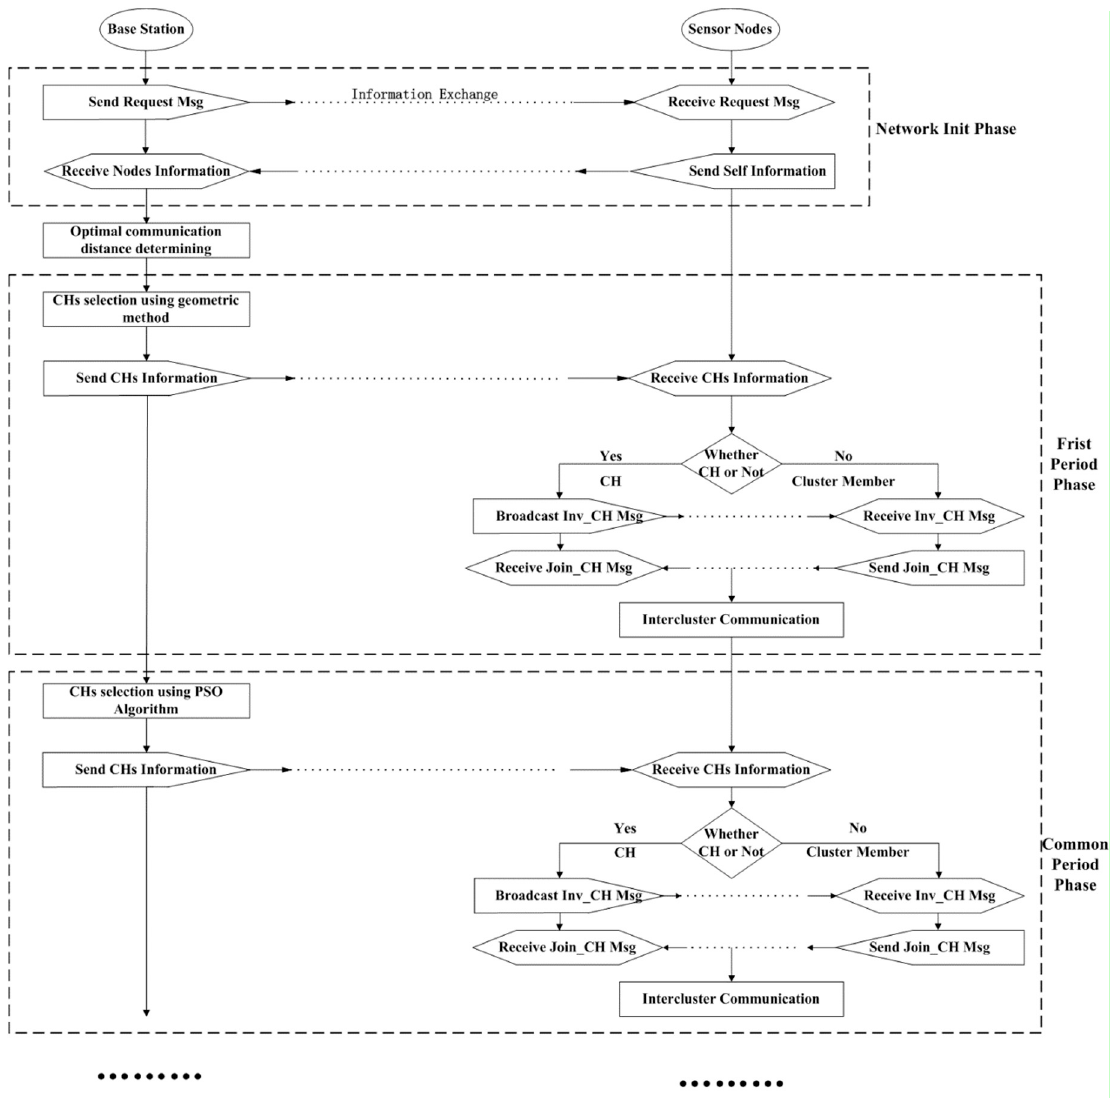
Figure 2. Network workflow.